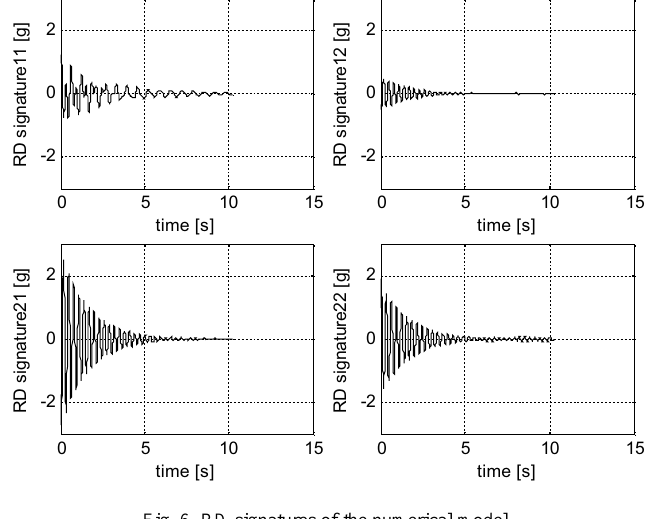
Fig. 6. RD signatures of the numerical model.